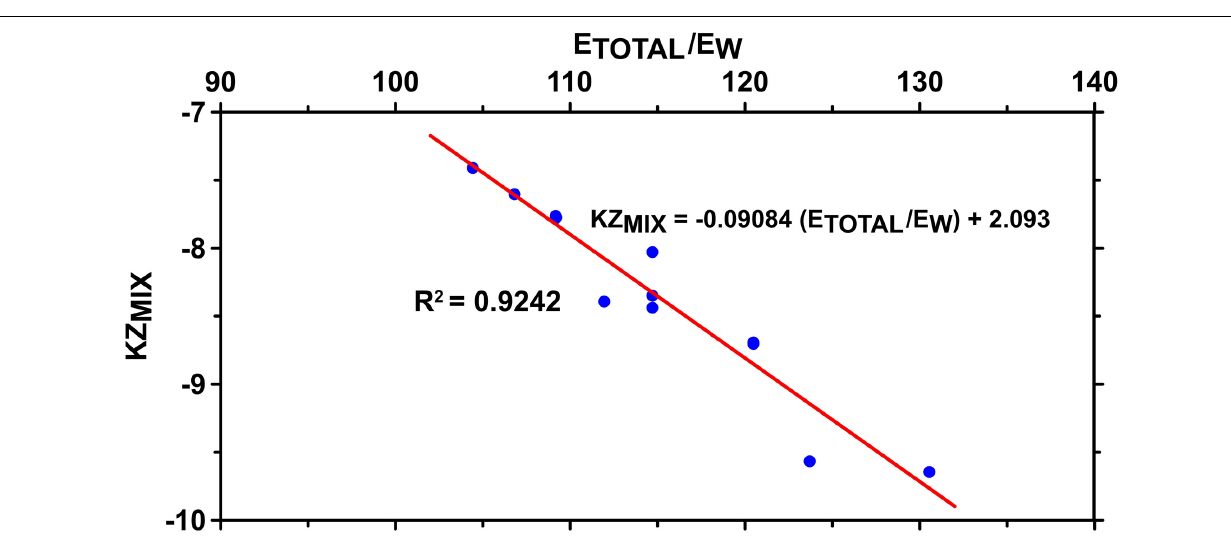
FIGURE 5 | Values of surface energy and mixing layer depth in the Aracati Bank area (blue dots) and adjusted linear regression (red line). Linear ratio between the total TKE (ET = EW + EWA) and its capacity for mixing the upper surface layers